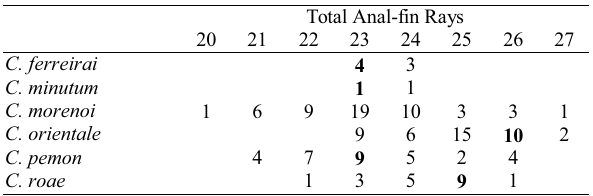
Table 4. Number of specimens of the species of Cetopsidium with cited number of total anal-fin rays. Bold indicates value for holotype when examined.